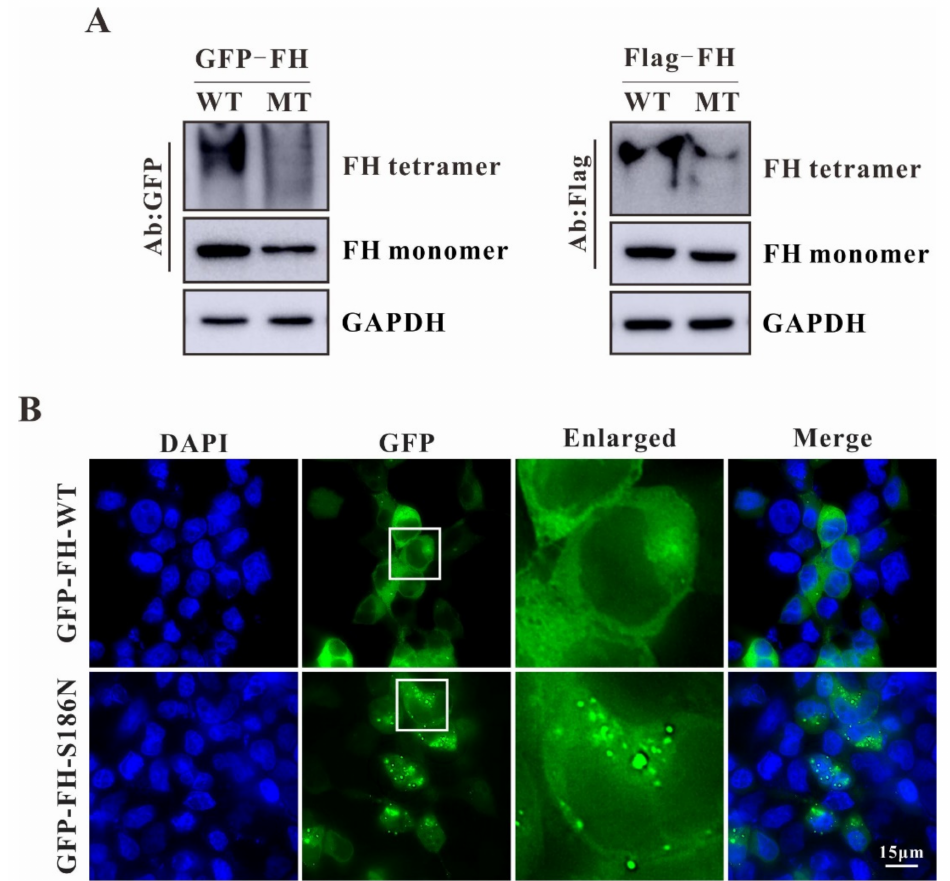
Figure 3. Abnormalities of fumarase homotetramer and localization with FH mutant. ( A ) Native gel electrophoresis was performed to analyze the FH tetramer formed in HEK293T cells expressing either flag tagged or GFP tagged FH wildtype and mutant, respectively. All data are presented from at least three separate experiments. ( B ) Immunofluorescence staining was performed in HEK293T cells transfected with GFP-FH-WT or GFP-FH-MT plasmids. Bar: 15 µ